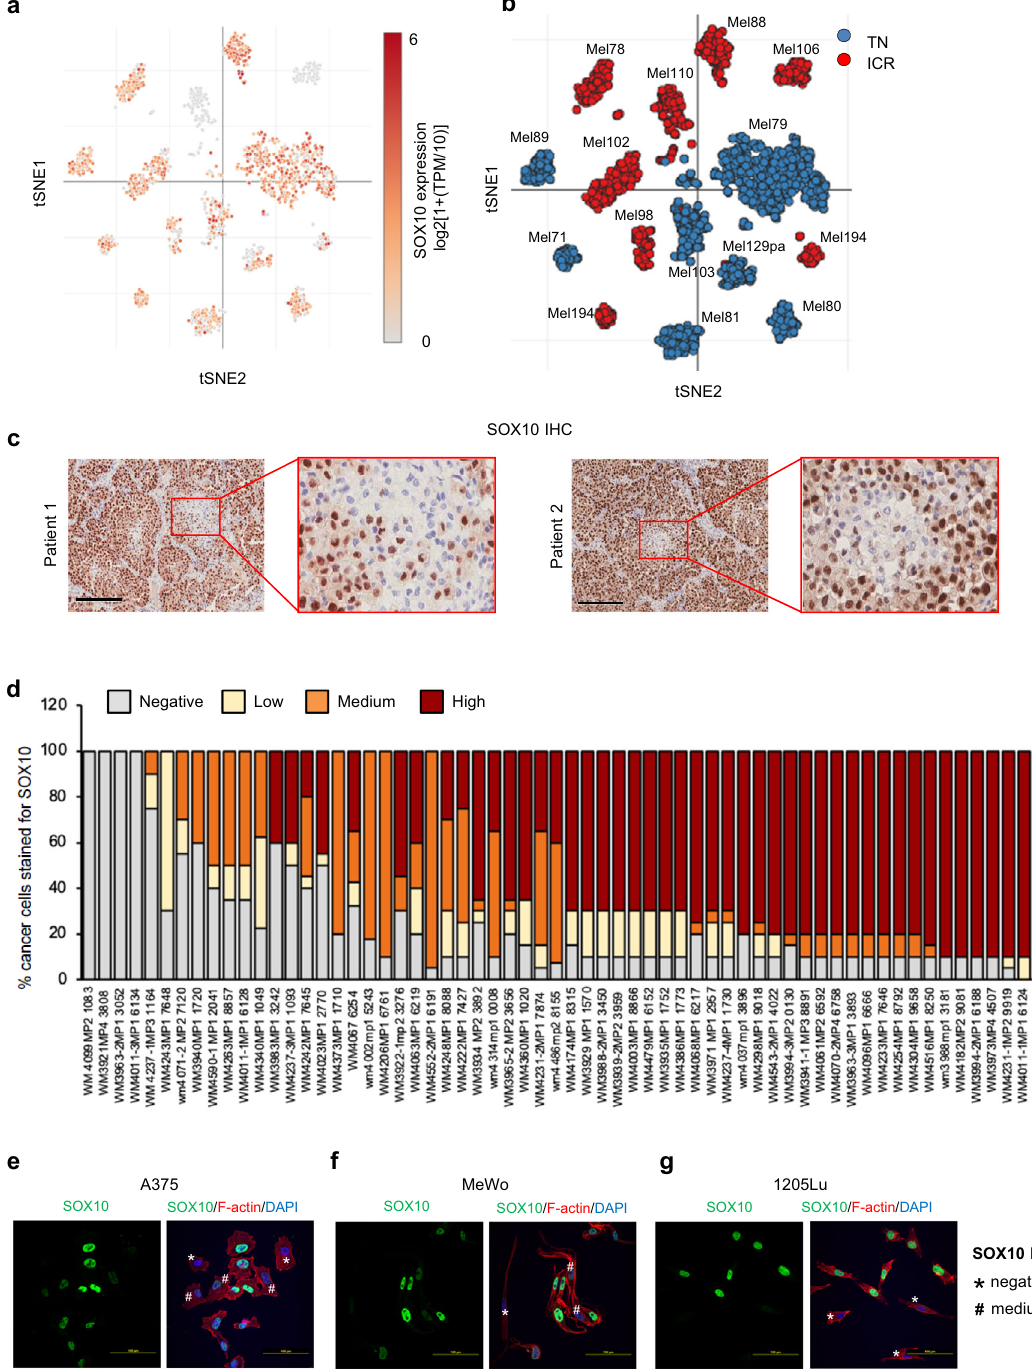
Fig. 1 Melanoma patient samples show heterogeneous SOX10 expression. a tSNE plot of scRNA-seq cells colored by SOX10 expression level from Jerby- Arnon, et al. b As in a except cells colored by treatment. c Melanoma patient samples from Thomas Jefferson Hospital stained for SOX10. Scale bars, 200 μ m. d TMA samples stained for SOX10. In each sample, the percentage of cancer cells expressing none, low, medium, or high levels of SOX10 was quanti fi ed by a pathologist (Dr. Xu). Samples were sorted based on their H-score (low to high). e Immuno fl uorescence images of A375, cells stained for SOX10 (green), fi lamentous actin (red), and DAPI (blue). The experiment was performed independently twice, and representative images are shown. Scale bar, 100 μ m. f As in e except MeWo cells were used. g As in e except 1205Lu cells were expression of SOX10, we analyzed SOX10 knockout cells by western blotting. We fi rst con fi rmed that, as previously suggested, SOX10 regulates the expression of ErbB3 22 and PDGFR β 16 .